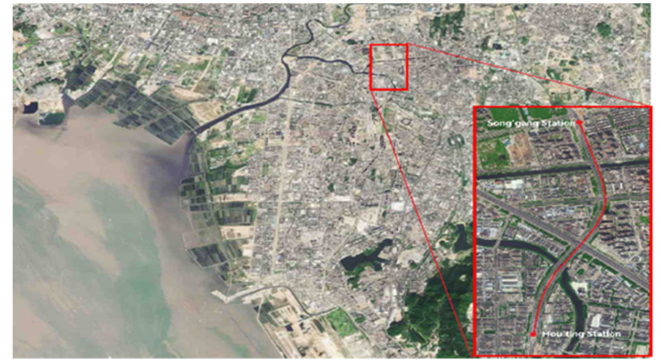
Figure 2. Schematic diagram of research area.